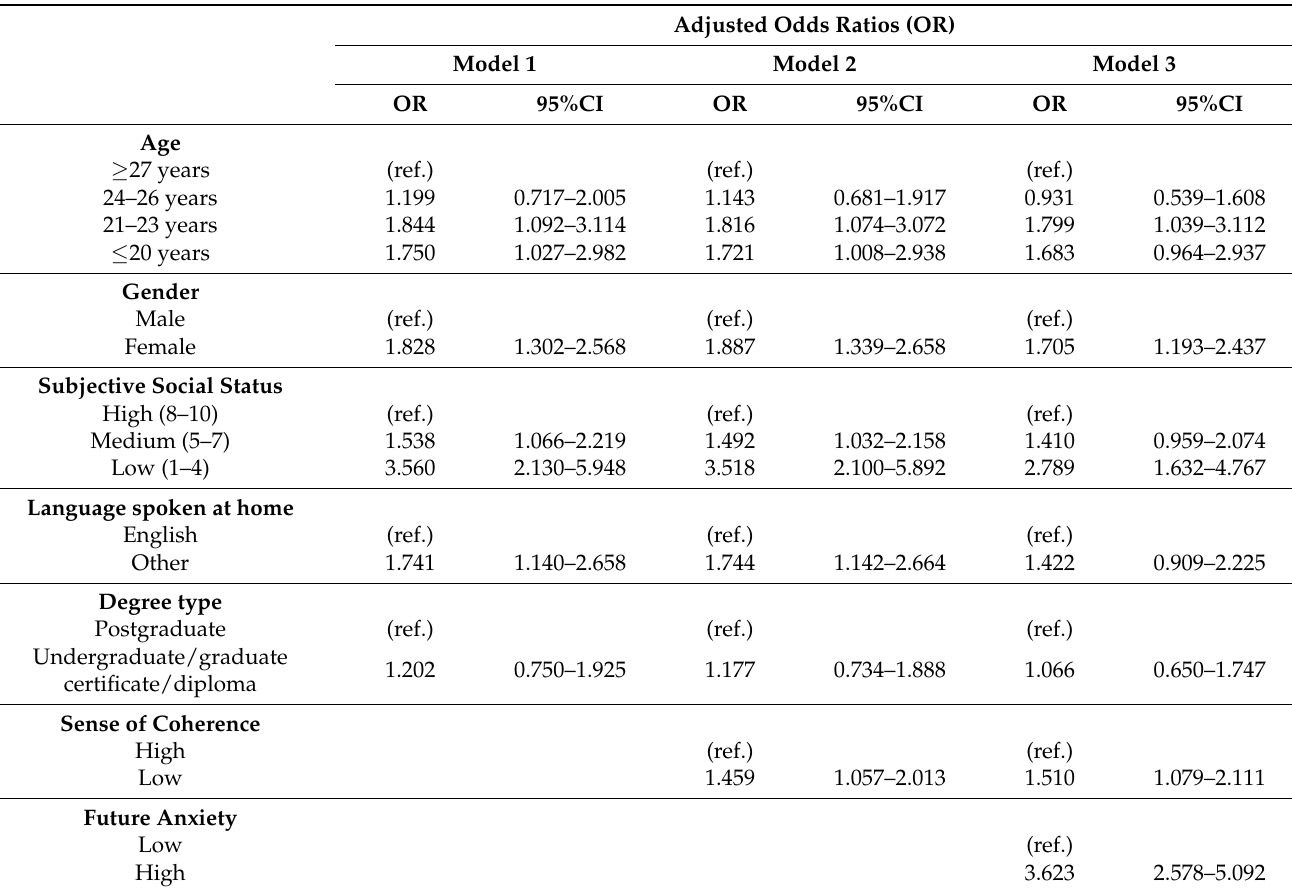
Table 4. Multivariable model examining sociodemographic factors associated with lower (<50) wellbeing (N = 765). Adjusted Odds Ratios (OR) Model 1 Model